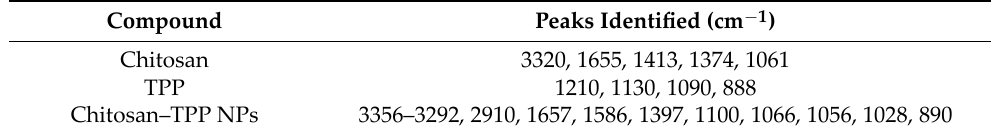
Table 2. Peaks identified for the tested samples in the FTIR assay. Compound